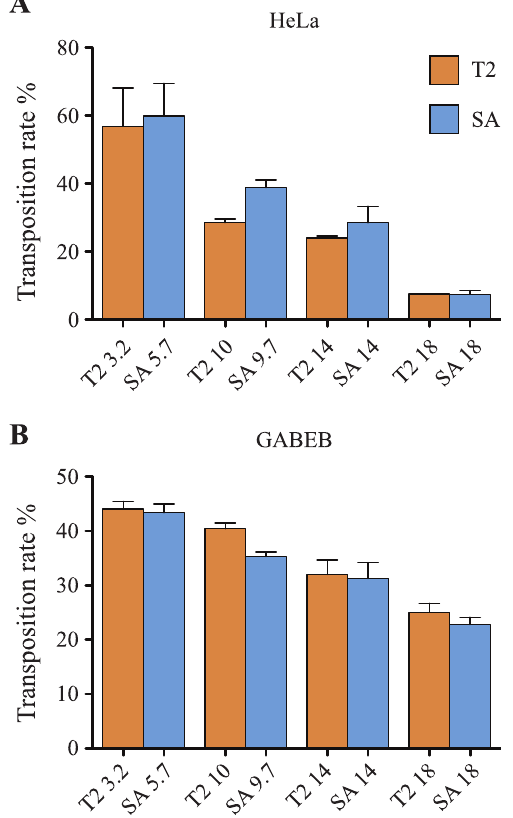
Figure 2. Transposition efficiency. HeLa (A) and GABEB (B) cells were co-transfected with the T2 and SA transposons- and transposase- carrying plasmids. The transposition rate, on the Y axis, is derived by the ratio between the percentage of Venus + cells at about 20 and 2 days post transfection. Data are representative of three independent experiments (mean 6 SEM; n